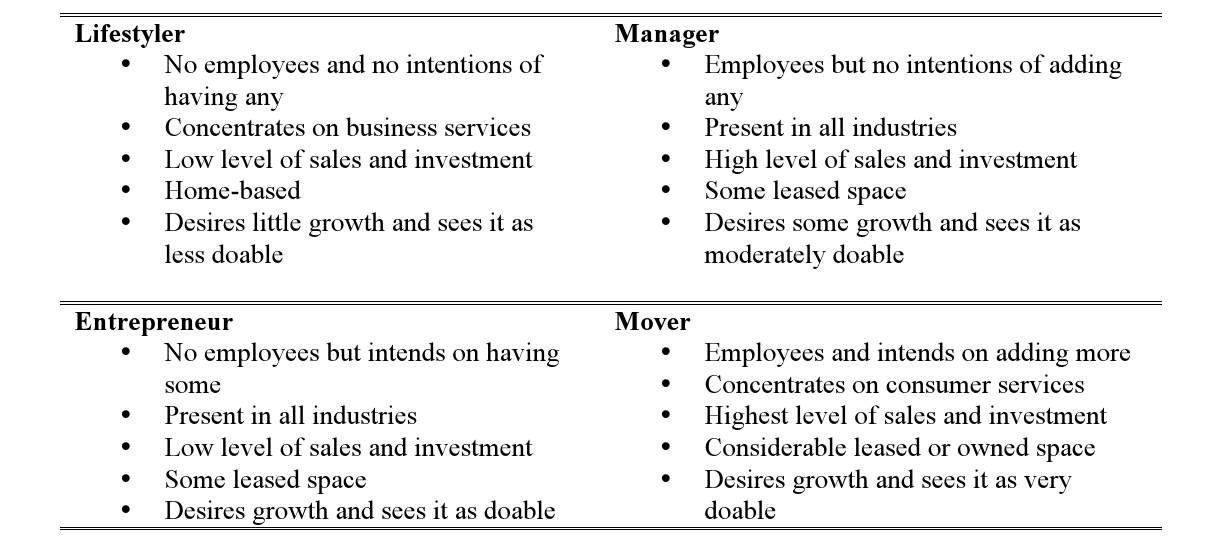
Figure 2. Profile of Four Types of Young